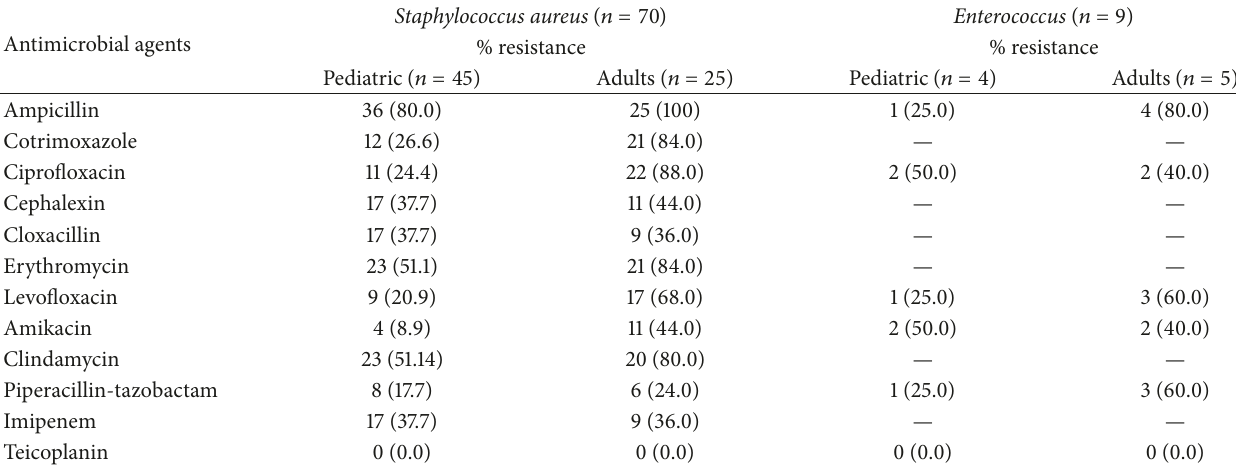
Table 5: Trends of antimicrobial susceptibilities of gram positive isolates ( 𝑛 = 79 ). Antimicrobial